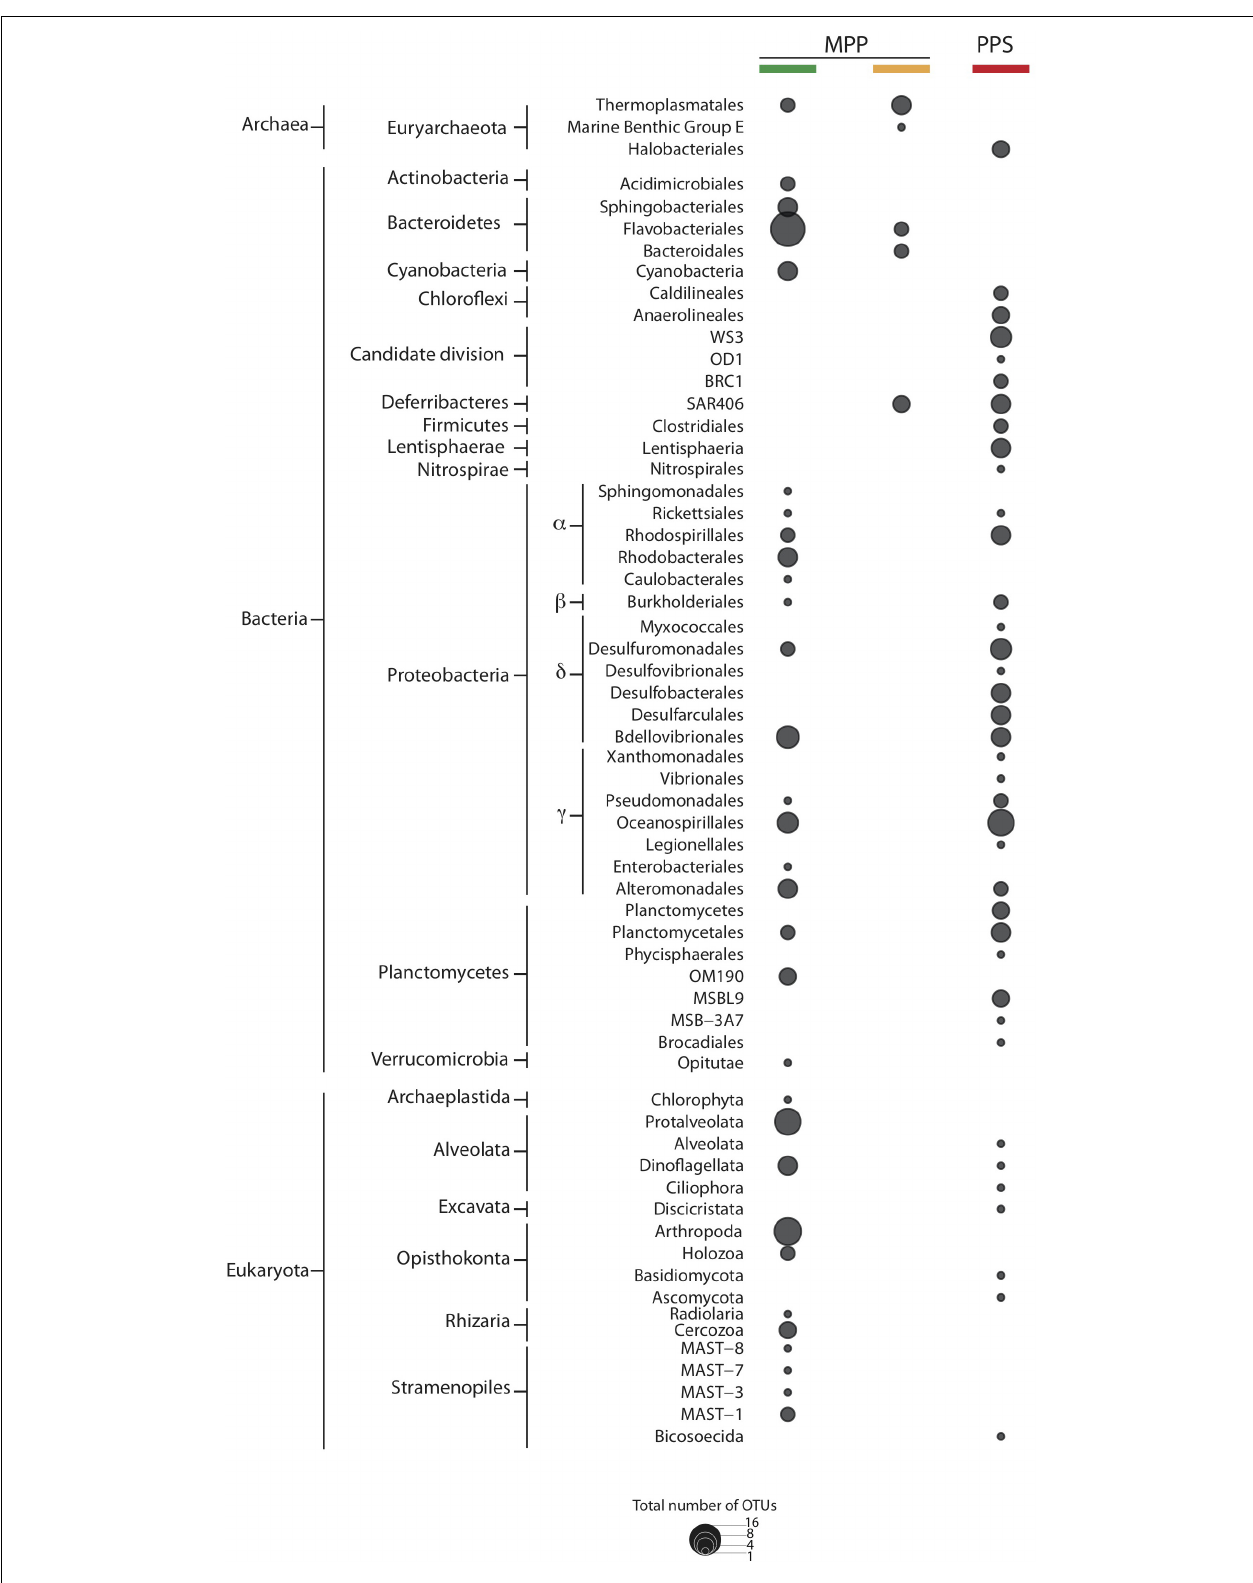
FIGURE 5 | Indicator OTUs for filter groups PPS in situ 0.4 µ m (red), and MPP on-ship 0.4 µ m (green), and 0.22 µ m with in-line 0.4 µ m prefilters (yellow). The size of dots depicts the total number of indicator OTUs affiliated to specific taxa.